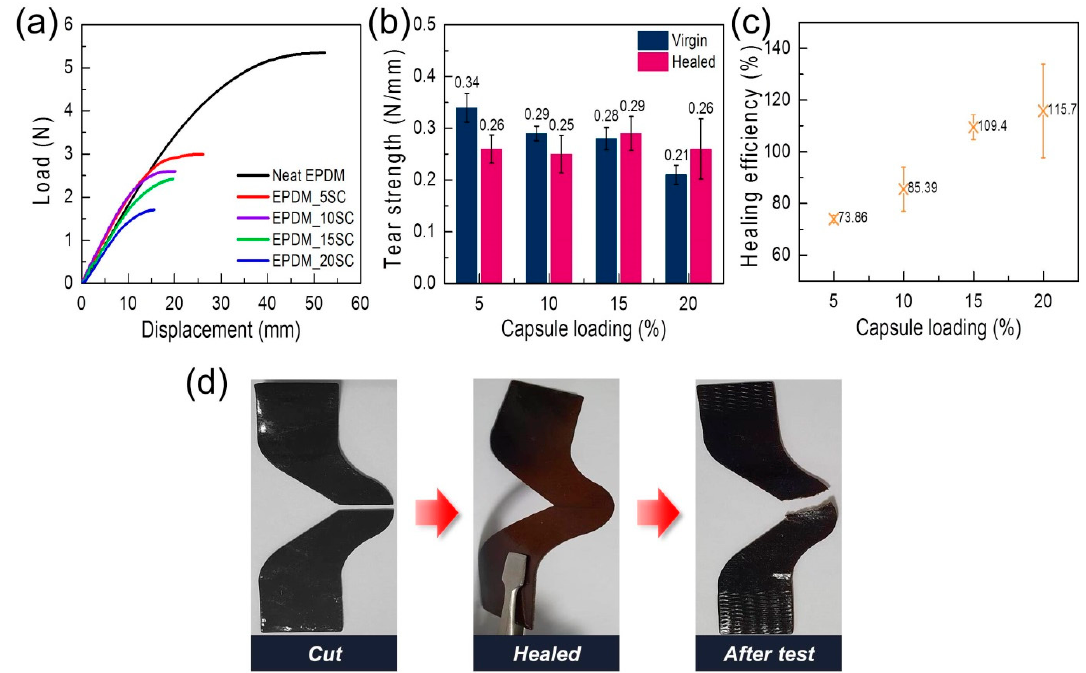
Figure 8. ( a ) Load-displacement curves of the EPDM/microcapsule rubber composites with varied amounts of the mechanically-enhanced UF microcapsules. ( b ) The tear strength values of the virgin and the healed EPDM/microcapsule rubber composites with varied amounts of mechanically-enhanced UF microcapsules. ( c ) The self-healing efficiencies of the EPDM / microcapsule rubber composites with varied amounts of mechanically-enhanced UF microcapsules based on the recovery of the tear strength. ( d ) The photo images of the cut and the healed EPDM_15SC, and the photo image of the EPDM_15SC torn by the tear test after the healing.